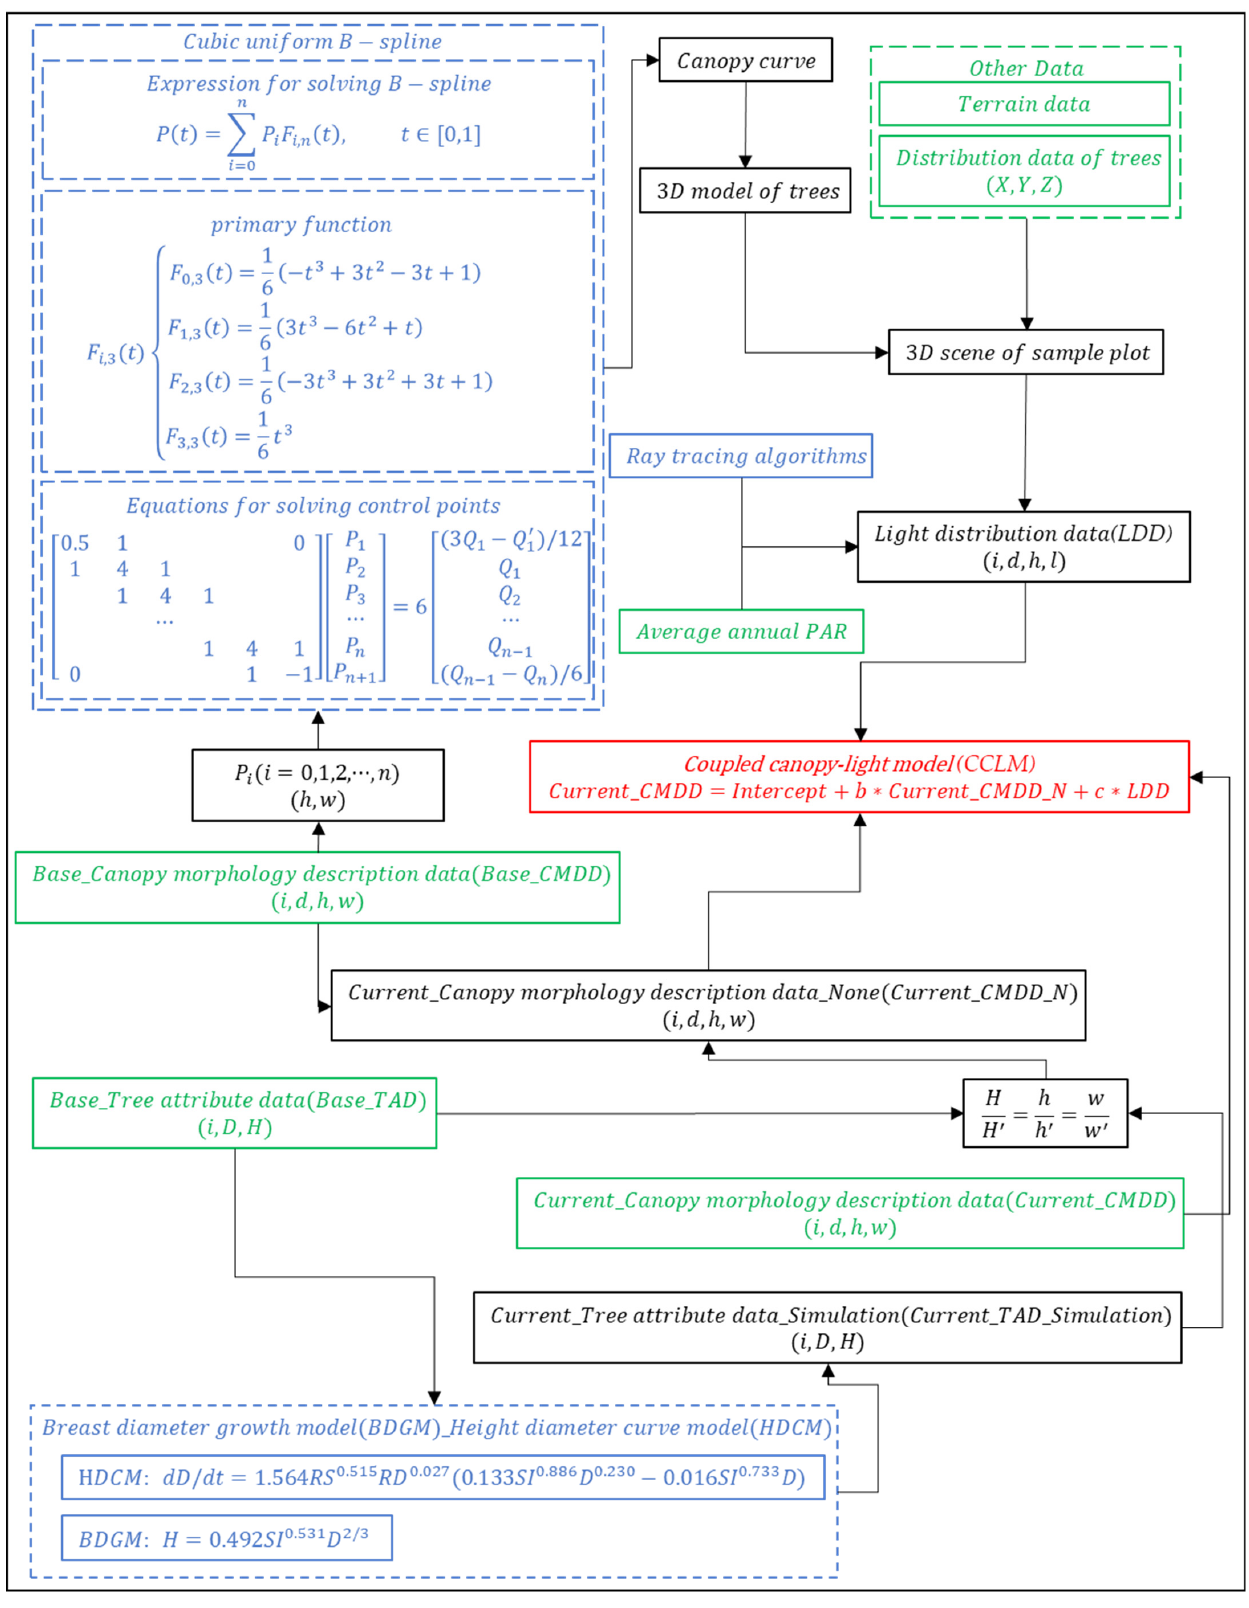
Figure 5. Coupled canopy–light model (CCLM).